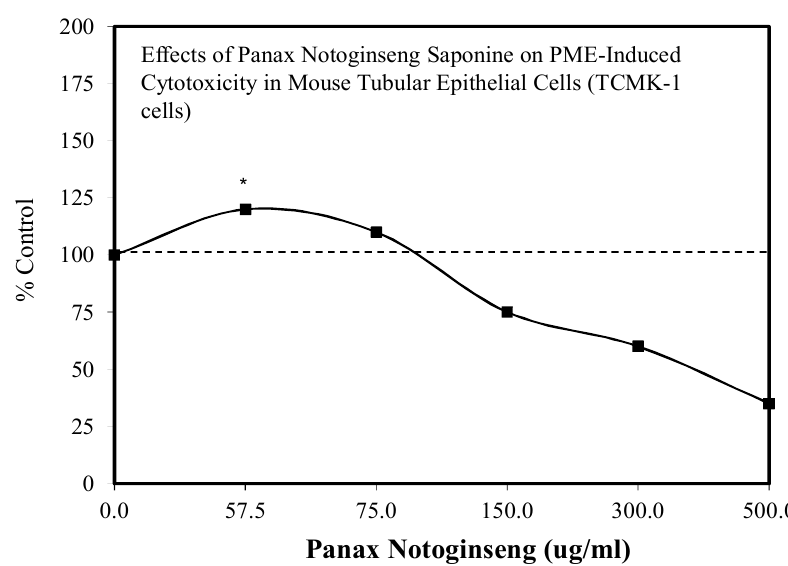
Figure 44. Korean Red Ginseng (KRG) prevented FK506-induced nephrotoxicity as measured by cell viability (MTT assay) in LLC-PK1 cells (source: [133]). Each * represent statistical significance for a data point.